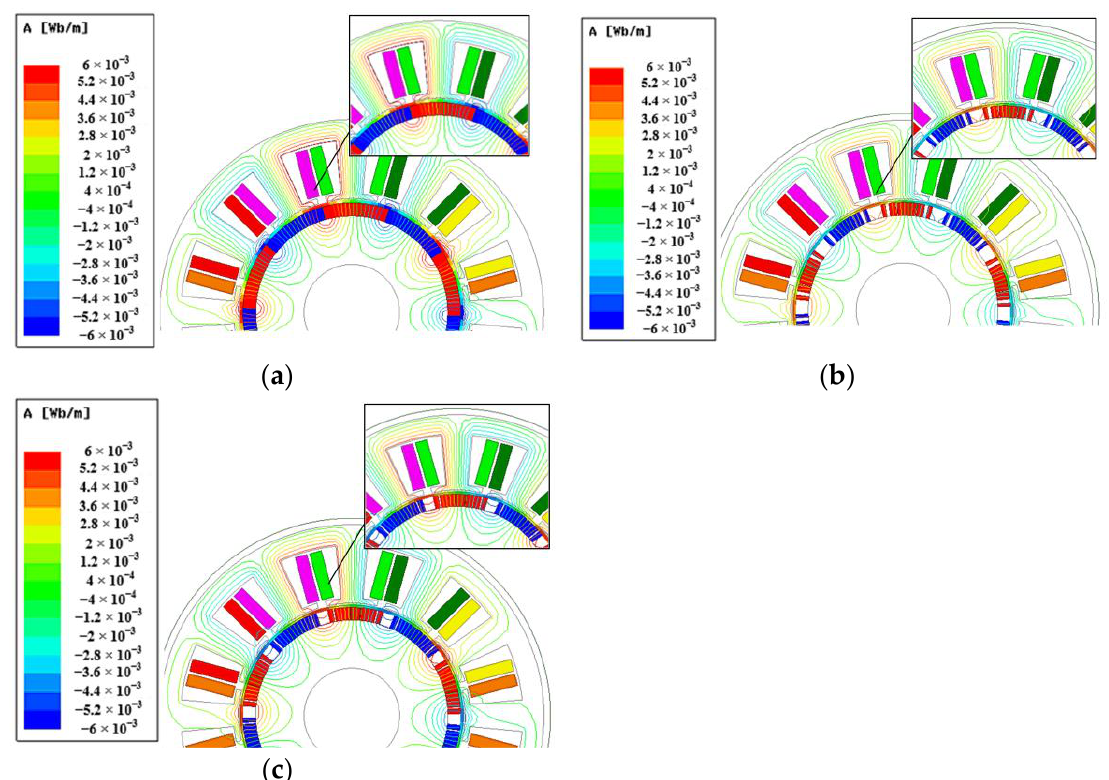
Figure 9. Comparison results of no-load flux of different pole structures: ( a ) conventional surface- mounted PM shape; ( b ) equivalent sinusoidal PM shape; ( c ) equivalent sin + 3rd PM